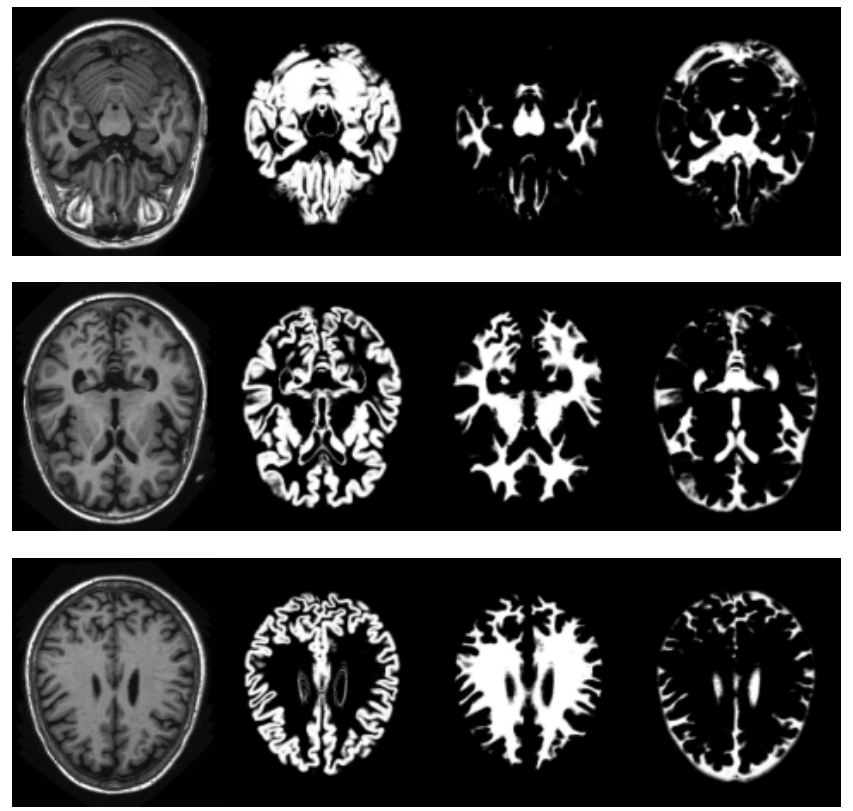
Figure 2. Volume slices, selected from the pre-processed OASIS-1 dataset, showing tissue segmentation examples. Original T1-weighted MRI slice ( left ), gray matter probabilities ( middle left ),white matter probabilities ( middle right ), cerebrospinal fluid ( right